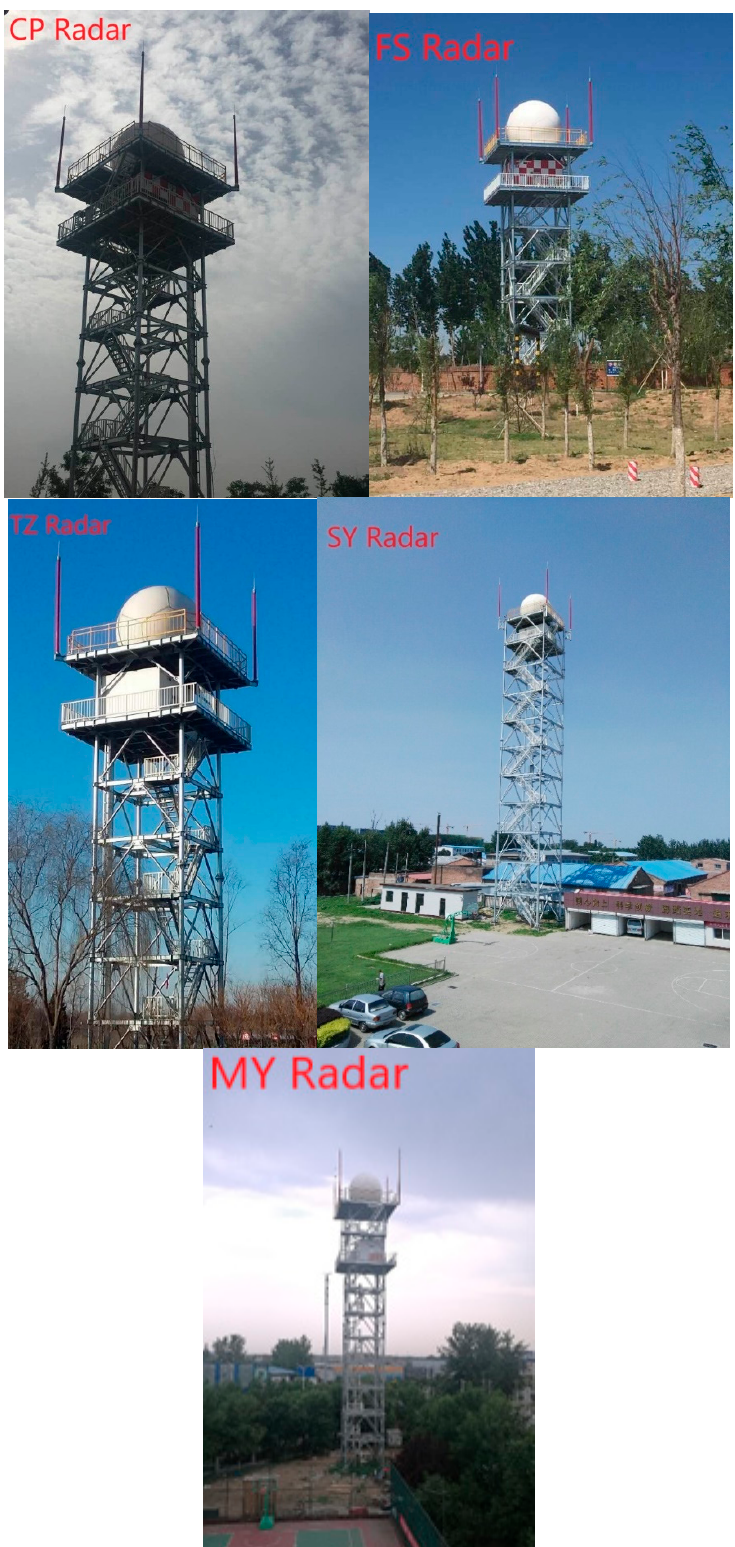
Figure 1. Installation of Beijing X-band dual-polarization radars(X-POL). The letter symbols, such as “CP”, correspond to the name of various radars. More information about the deployment of the five radars can be found in Table 1.